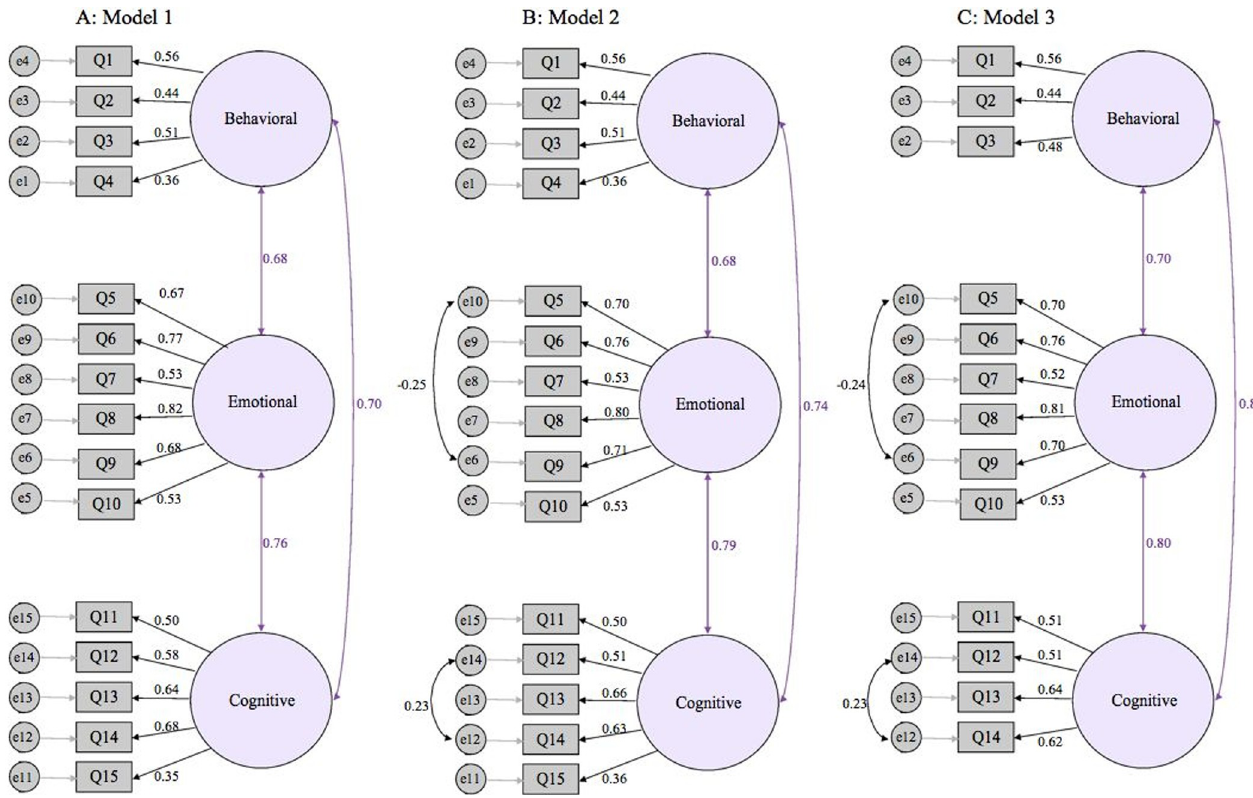
Fig 1. Standardized regression weights in (A) Model 1: an initial confirmatory factor analysis model of the 15-item SEC-RU scale, (B) Model 2: a revised confirmatory factor analysis model of the 15-item SEC-RU scale, and (C) Model 3: a final confirmatory factor analysis model of a 13-item SEC-RU scale.